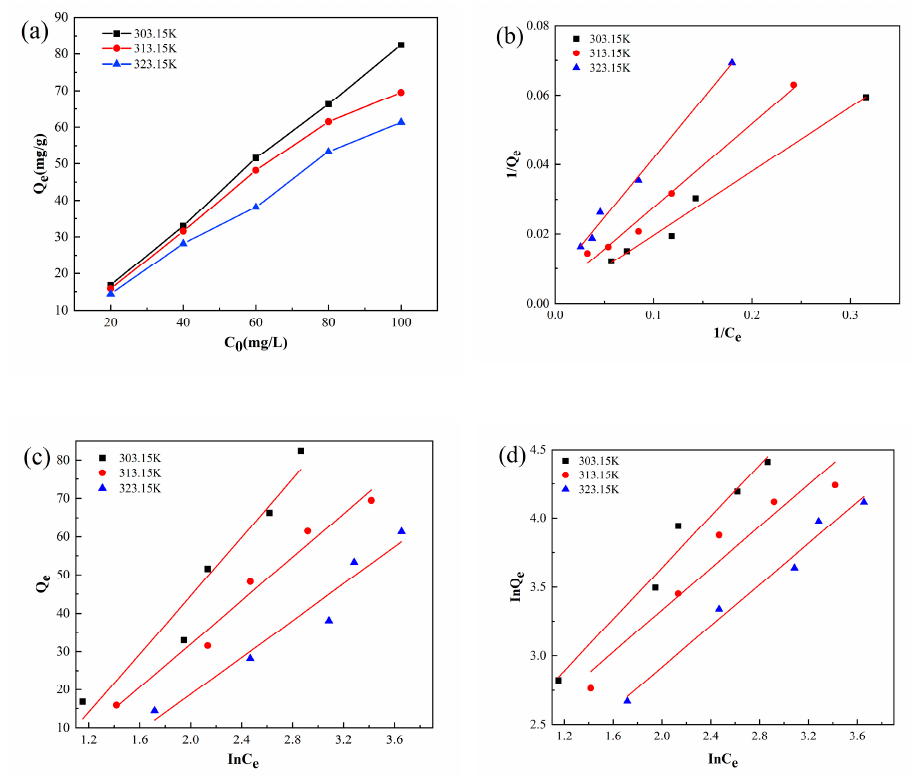
Figure 10. Iron tailing adsorption isotherm of GO ( a ), Langmuir ( b ), Freundlich ( c ) and Temkin ( d ) isotherm equation fitting curves.